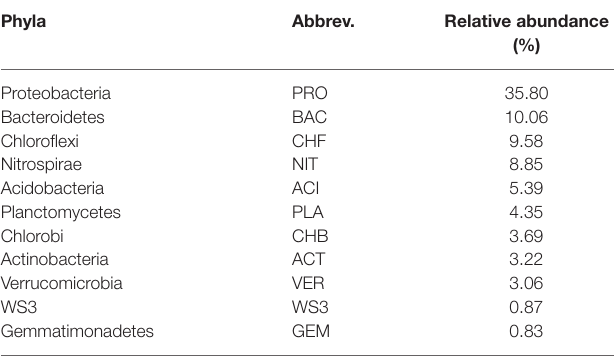
TABLE 1 | Abbreviations for the abundant